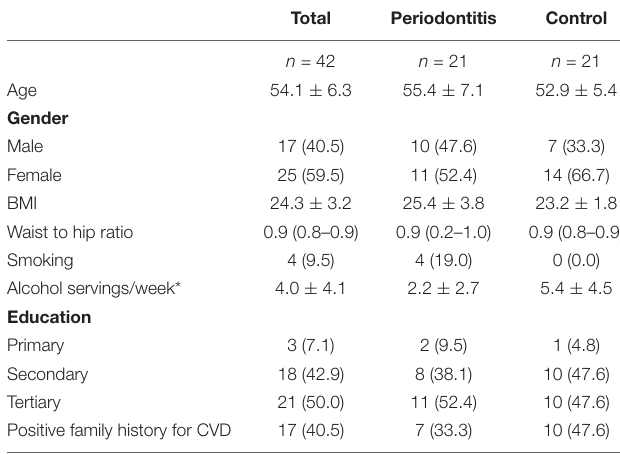
TABLE 1 | Characteristics of the study